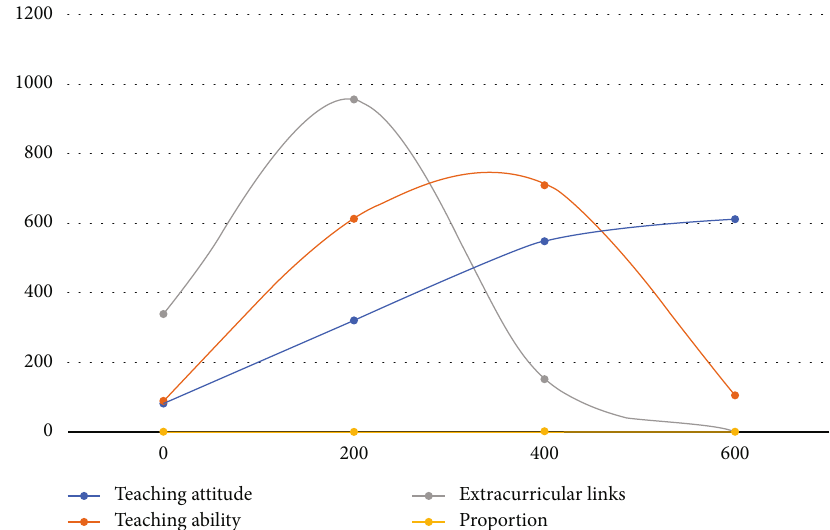
Figure 7: Statistical table of students ’ teaching evaluation in a certain semester of Y school.